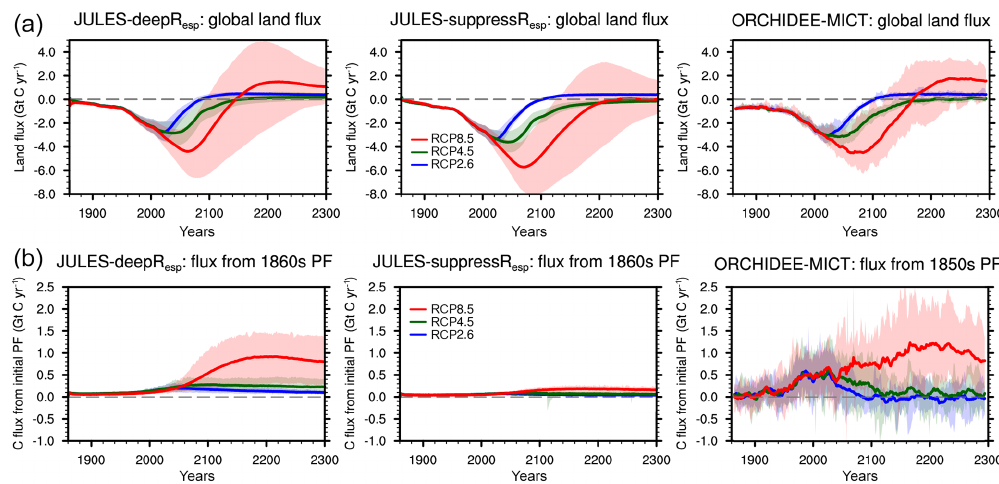
Figure 6. Global land CO 2 flux to the atmosphere (positive is a release to the atmosphere) for the permafrost enabled simulations (PF, a ). (b) shows the impact of adding permafrost carbon on the global flux of land carbon to the atmosphere, and its associated feedback via the climate system (difference between PF and non-PF simulations, i.e. PF minus non-PF).